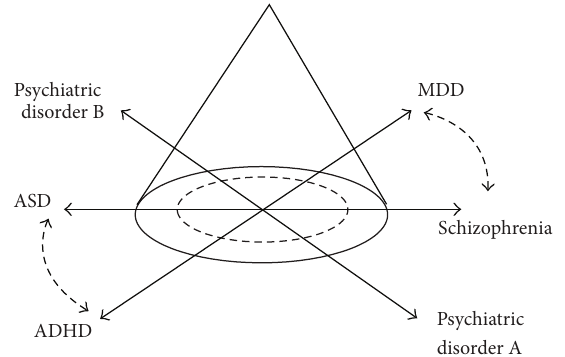
Figure 3: A schematic diagram illustrating that psychiatric disor- ders may be understood to be occurring on a spectrum with pairs of conditions with diametrical